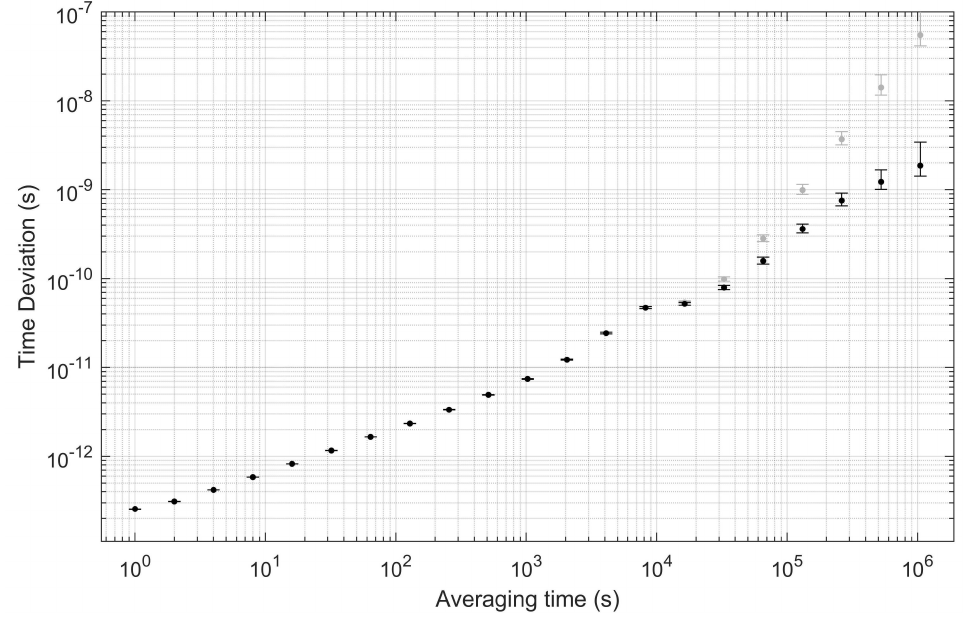
Figure 4. Time deviation determination of optical clock stability after removing the effect of helium by fitting and subtracting an exponential decay function (black circles). Additionally shown in gray markers is the time deviation for the same data prior to removal of the drift. At one day (86,400 s), the time deviation is approximately 200